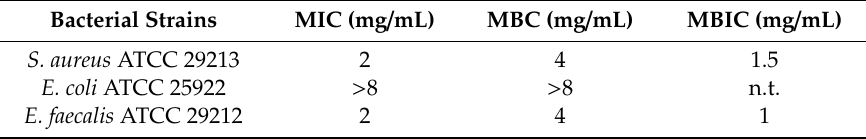
Table 1. Evaluation of the minimum inhibitory concentration (MIC), minimum bactericidal concentration (MBC), and minimum biofilm inhibitory concentration (MBIC) of the medical device (MD) against S. aureus , E. coli , and E.